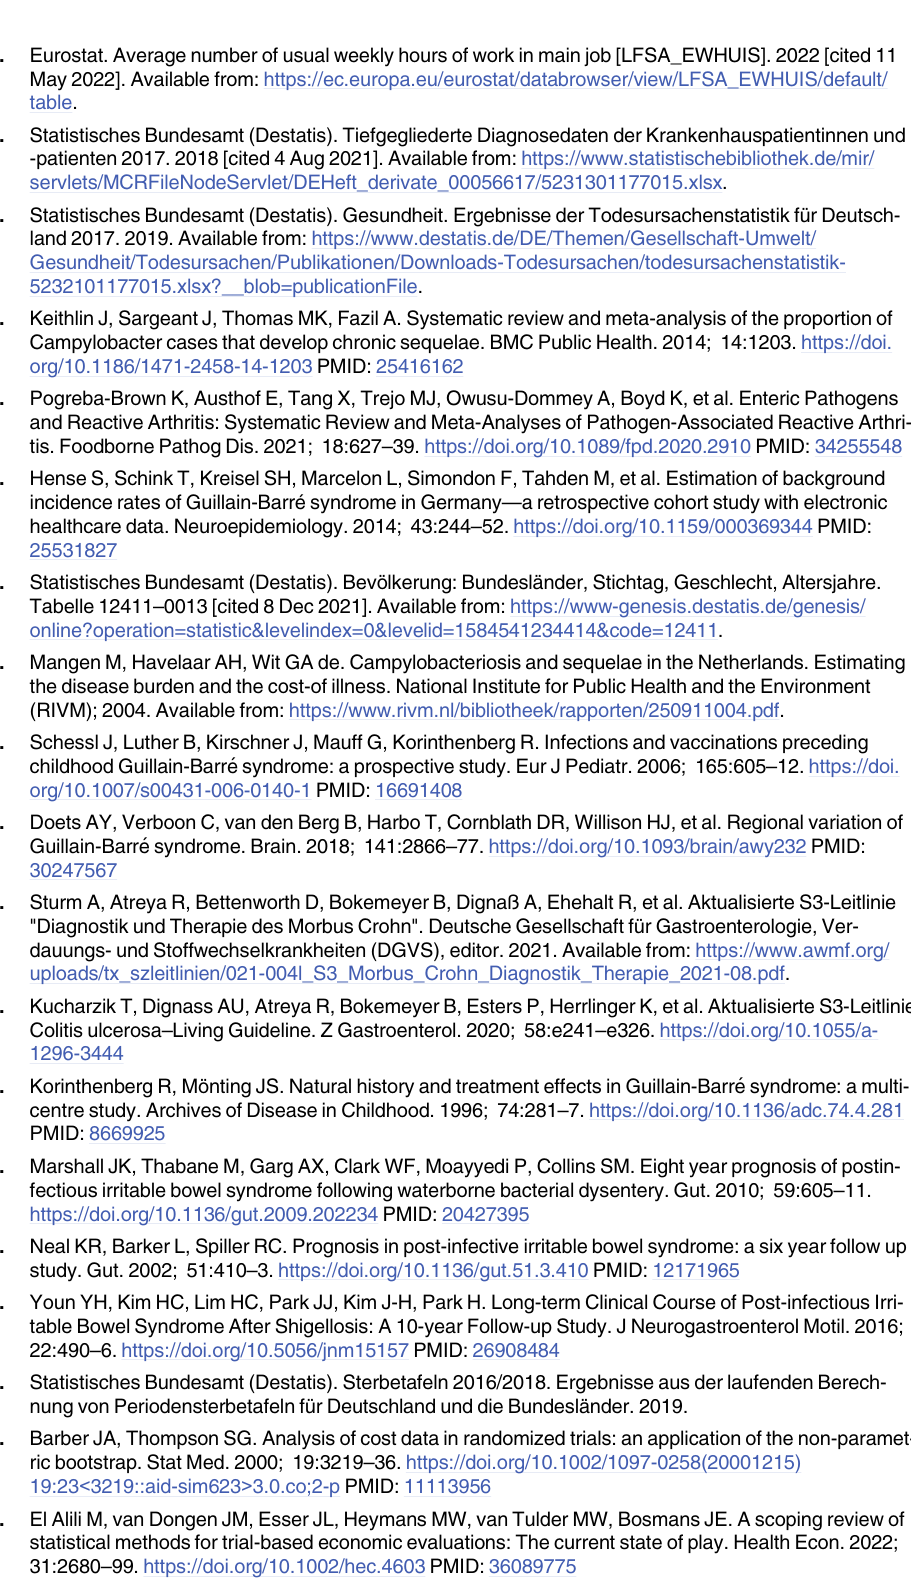
36. StatistischesBundesamt (Destatis). Tiefgegliederte Diagnosedaten der Krankenhauspatientinnenund -patienten2017. 2018 [cited 4 Aug 2021]. Availablefrom: https://www.statistischebibliothek.de/mir/ servlets/MCRFileNodeServlet/DEHeft_derivate_00056617/5231301177015.xlsx. 37. StatistischesBundesamt (Destatis). Gesundheit. Ergebnisse der Todesursachenstatistik fu¨r Deutsch- land 2017. 2019. Availablefrom: https://www.destatis.de/DE/Themen/Gesellschaft-Umwelt/ Gesundheit/Todesursachen/Publikationen/Downloads-Todesursachen/todesursachenstatistik-